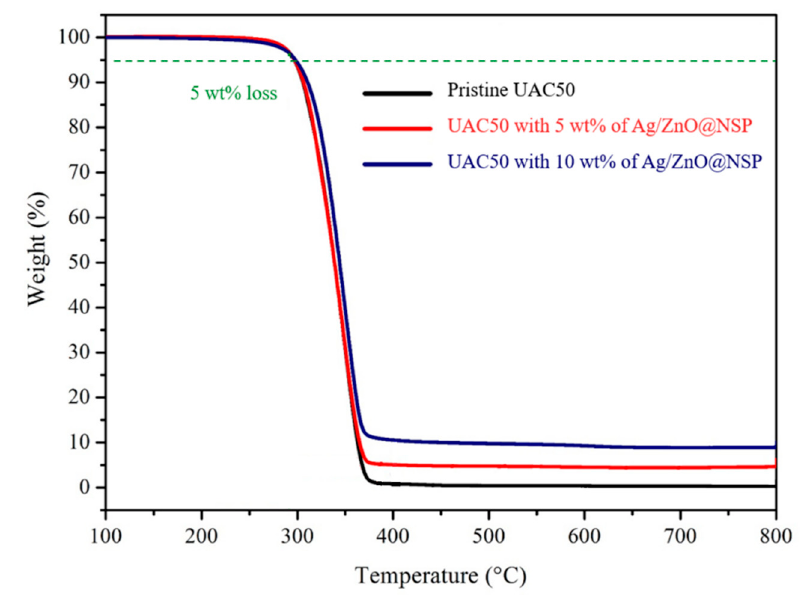
Figure 6. Thermogravimetric analysis (TGA) thermograms of UAC50- and UAC50-based composites.